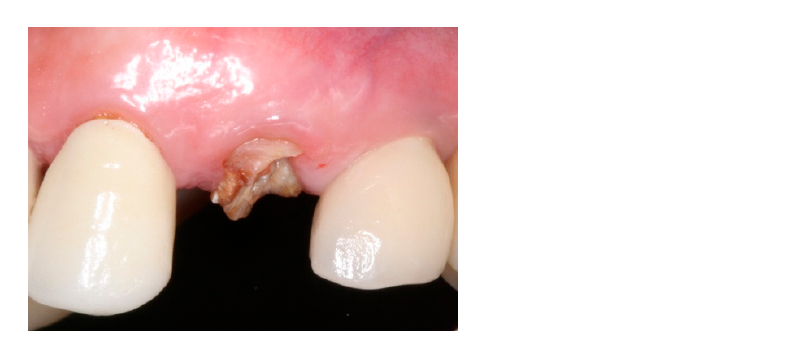
Figure 3. Intraoral buccal view of #24, with a limited dental structure after fractured crown.